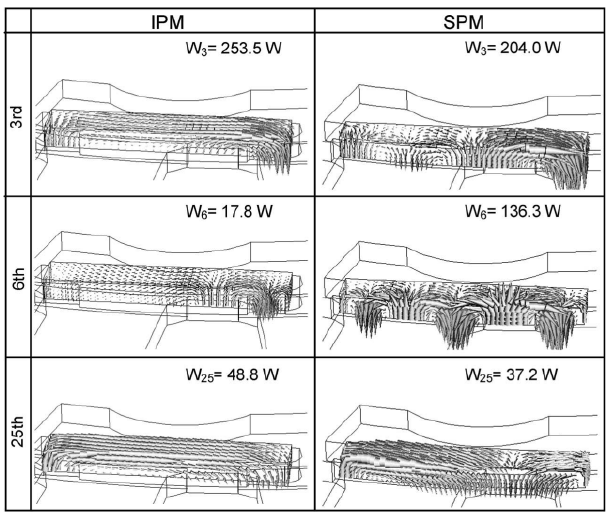
Figure 10. Eddy current paths associated with different harmonics at 300 A and β = 60 ◦ [59].